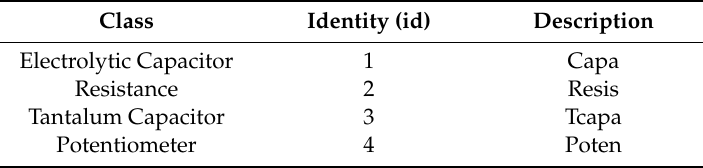
Table 2. The corresponding labels for four types of electronic